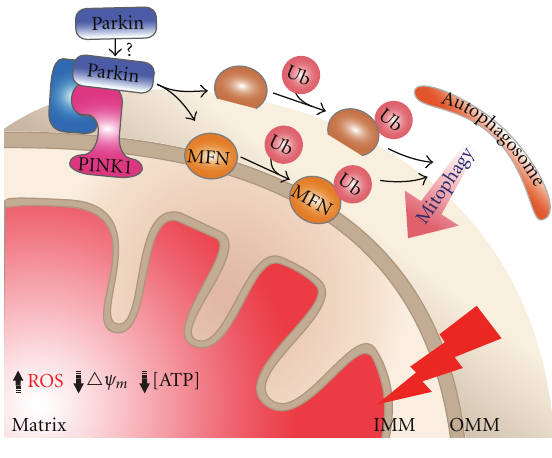
Figure 3: The PINK1/Parkin pathway mediates mitochondrial elimination via mitophagy. Accumulation of ROS and other toxic molecules can damage mitochondria, resulting in the loss of mitochondrial membrane potential and eventually the reduc- tion in mitochondrial ATP concentration. Loss of mitochondrial membrane potential triggers the accumulation of PTEN-induced kinase 1 (PINK1) on the mitochondrial outer membrane (OMM). The accumulation of PINK1 recruits the cytoplasmic E3 ubiquitin ligase, Parkin, to the damaged mitochondria. The mechanism of this recruitment is still unclear; however, several models have been proposed, in which the substrates shared by PINK1 and Parkin may play a role in mediating their interaction. Once on the mito- chondria, Parkin ubiquitinates various OMM proteins, including the mitochondrial profusion protein, mitofusin 1. Polyubiquitin chains on these proteins serve as a signal for the recruitment of the autophagosome that engulfs and degrades the damaged mitochondrion through a process called